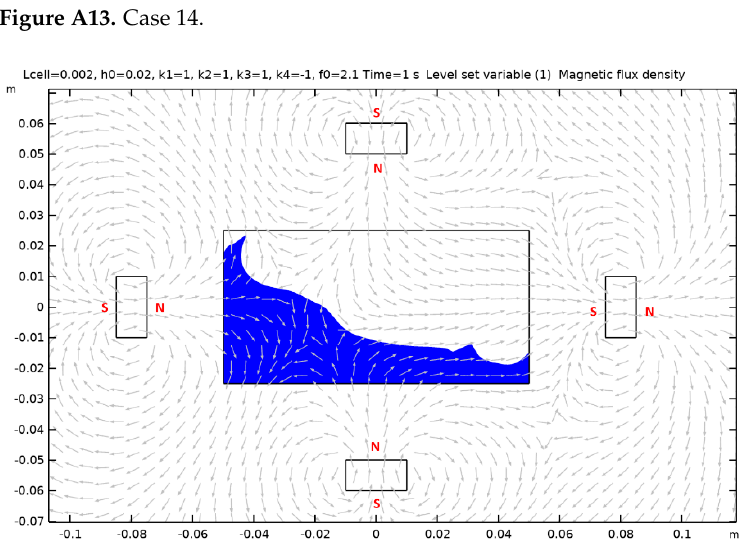
Figure A14. Case 15.